Question: Author a descriptive caption for the visualization shown.
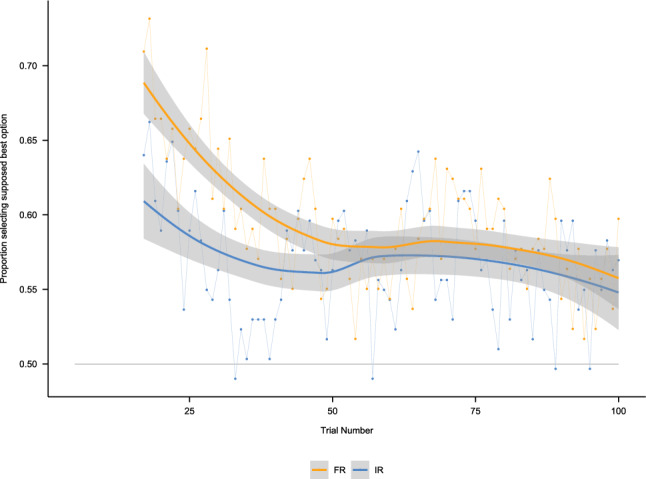
Answer: Proportion of choices for the supposed best option across trials in Experiment 1. Note. This figure represents the smoothed conditional means of the proportion of participants selecting the supposed best option in each trial. It was generated using the ‘geom_smooth()’ function from the R package ggplot2 (Whickham, 2016 ) and does not depict the linear models estimated for this dataset